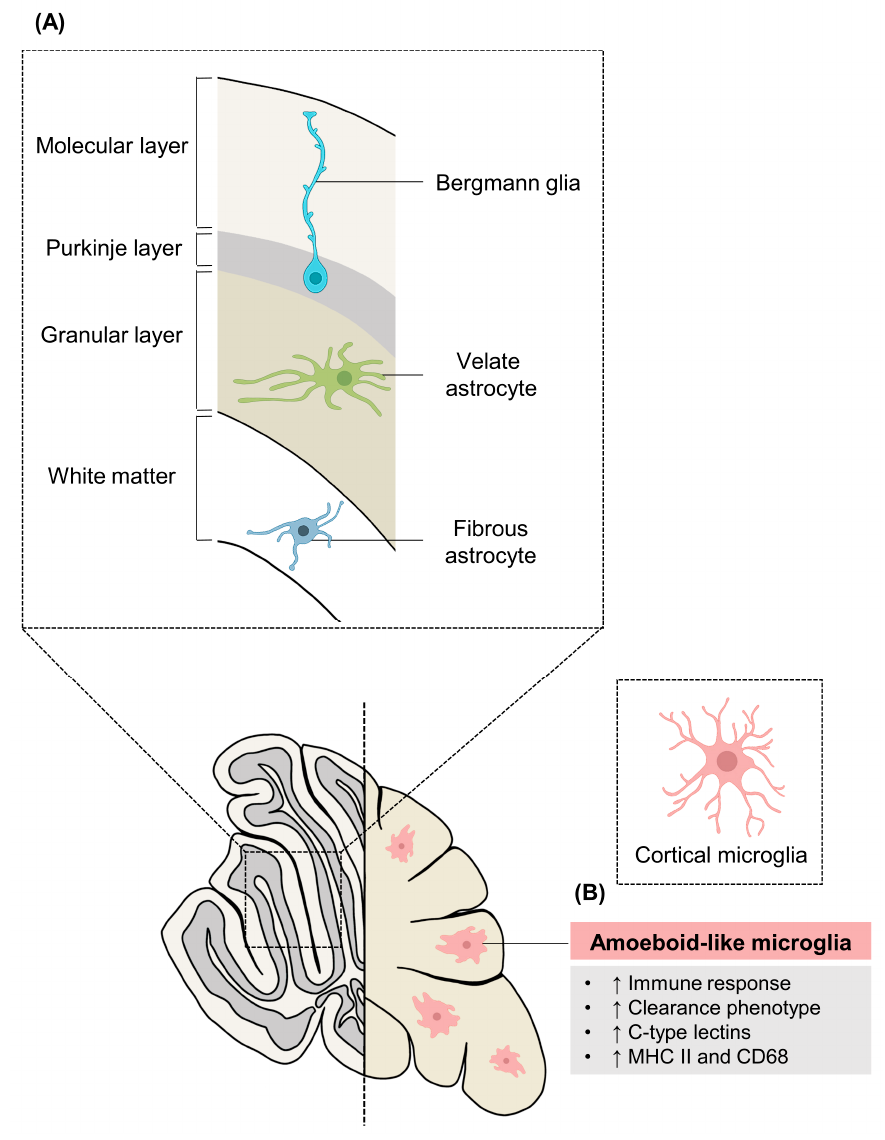
Figure 3. Intra- and inter-regional heterogeneity of cerebellum-specific astrocytes and microglia. ( A ) Three types of cerebellum-specific astrocytes are found in different layers of cerebellar cortex and white matter. Bergmann glia, which interact with Purkinje cells, are located in the molecular and Purkinje layer, while velate astrocytes are located in the granular layer. Fibrous astrocytes that regulate myelination and glutamate homeostasis are located in the white matter of cerebel- lum. ( B ) Cerebellum-specific microglia have distinct characteristics when compared to the cortical microglia. Morphology-wise, the cerebellum-specific microglia have smaller soma area, larger cy- toplasm area, and lower ramification, mimicking amoeboid-like morphology. Functional-wise, the cerebellum-specific microglia show greater immune response and debris-clearance. MHC II, major histocompatibility complex